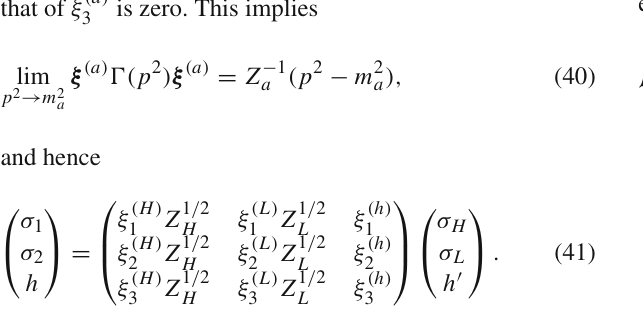
( a ) ( a ) and ξ is one, while 1 2